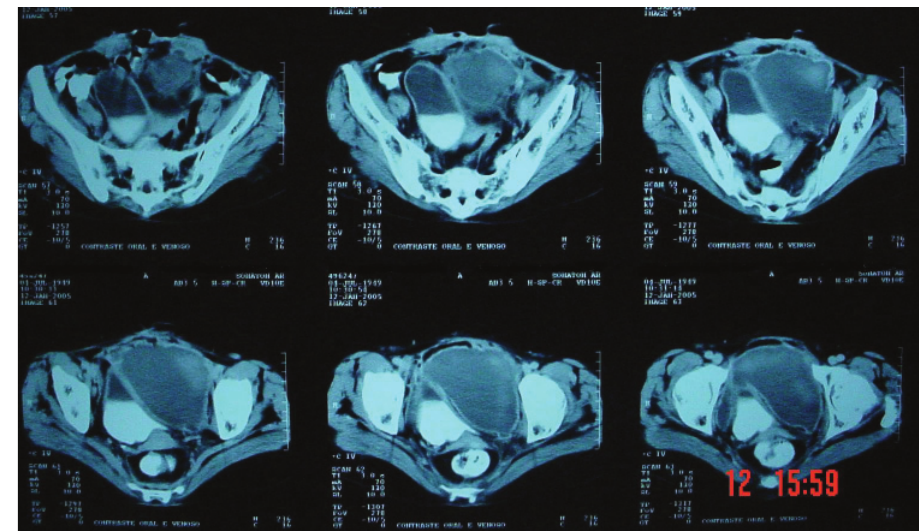
Figure 1 - Computed tomography showing a large retroperitoneal hematoma, shifting the rectum and bladder to the right.